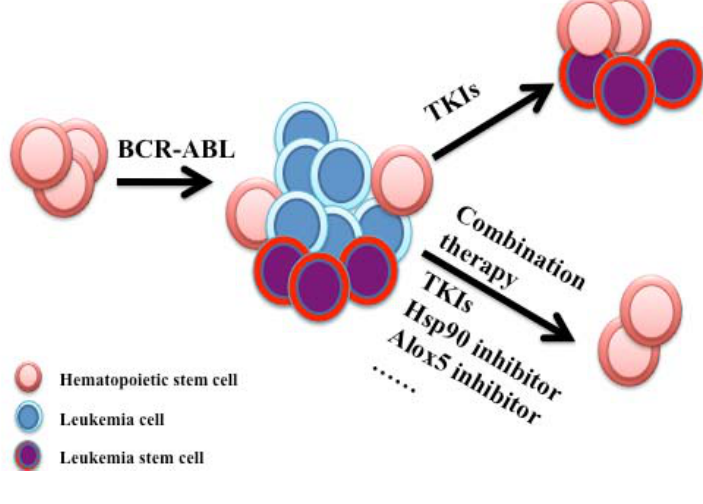
Figure 3. Strategies for targeting leukemia stem cells. BCR-ABL transforms a hematopoietic stem cell into a leukemia stem cell, subsequently giving rise to CML. Treatment with TKIs inhibits BCR-ABL activity and eliminate proliferative leukemia cells. However, residual leukemia stem cells are persistent with TKI treatment. Combination therapy with a TKI and a Hsp90 inhibitor or Alox5 inhibitor will be a promising therapeutic strategy for targeting leukemia stem